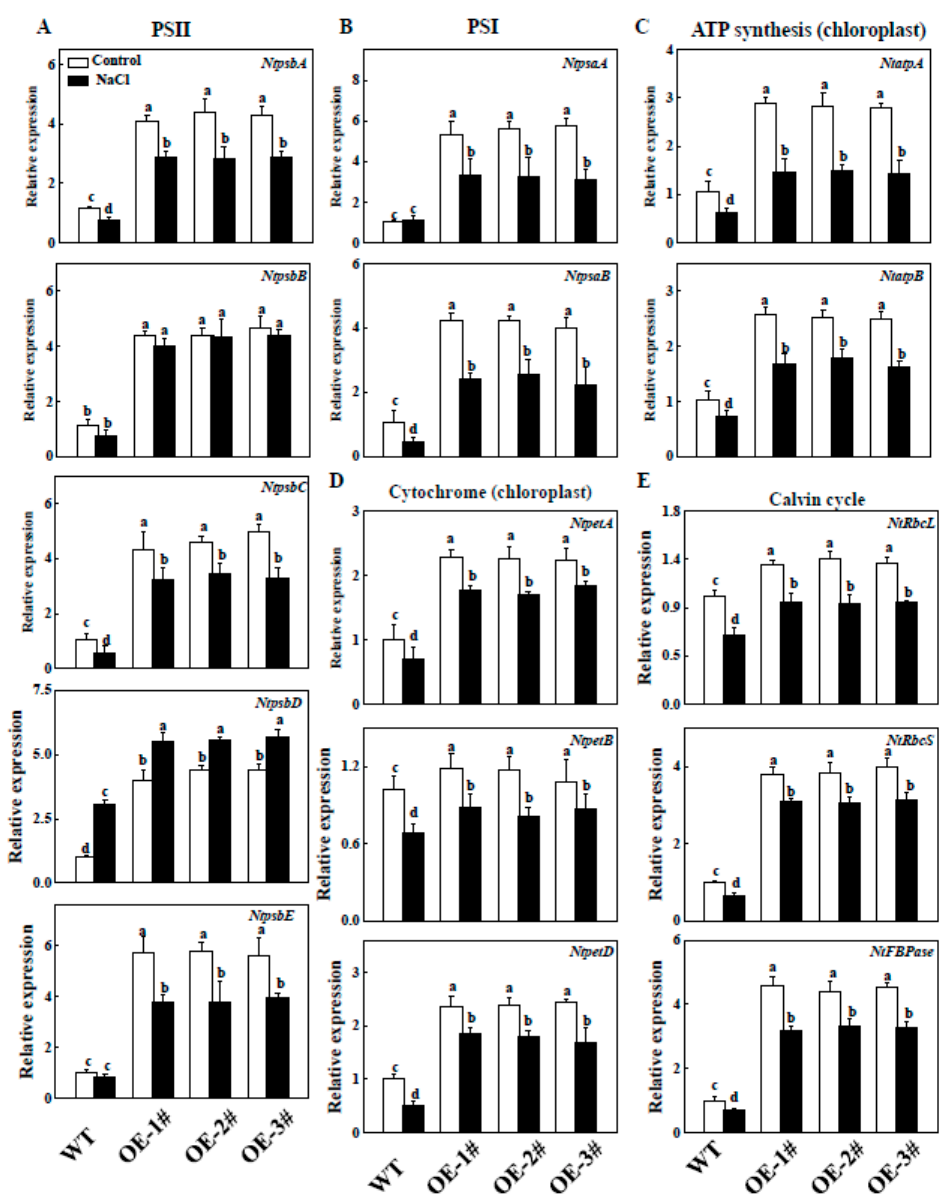
Figure 10. Expression of PSII ( A ); PSI ( B ); Cytochrome ( C ); ATP synthesis ( D ); Calvin cycle-related genes ( E ) in WT and CsTGase OE plants under salt stress. Each histogram represents a mean ± SE of four independent experiments ( n = 4). Different letters indicate significant differences between treatments ( p < 0.05) according to Duncan’s multiple range test.